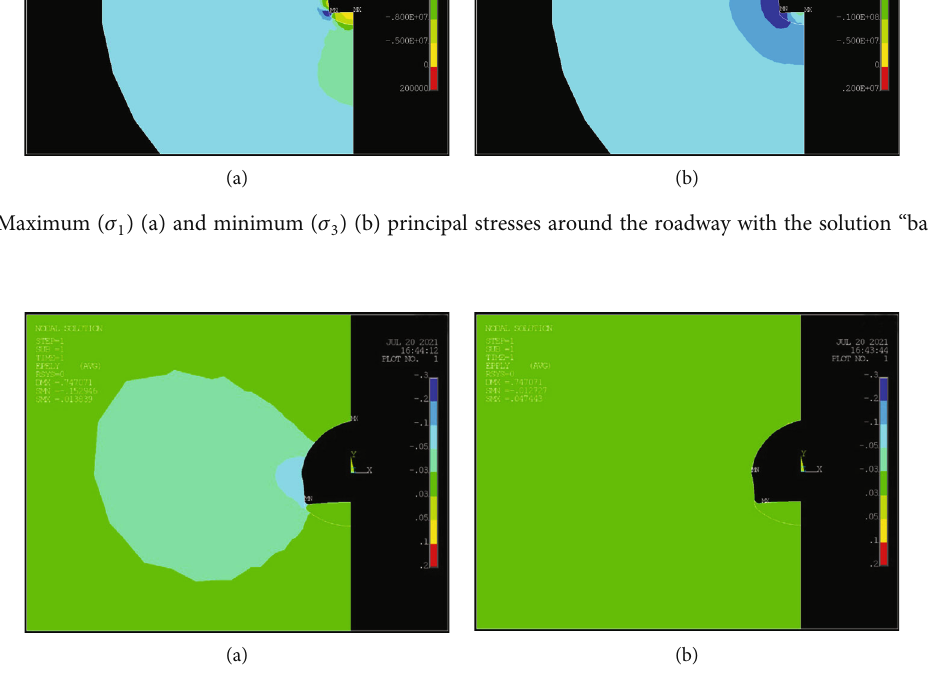
Figure 6: Vertical elastic (a) and plastic (b) strains around the roadway with the solution “ base ”